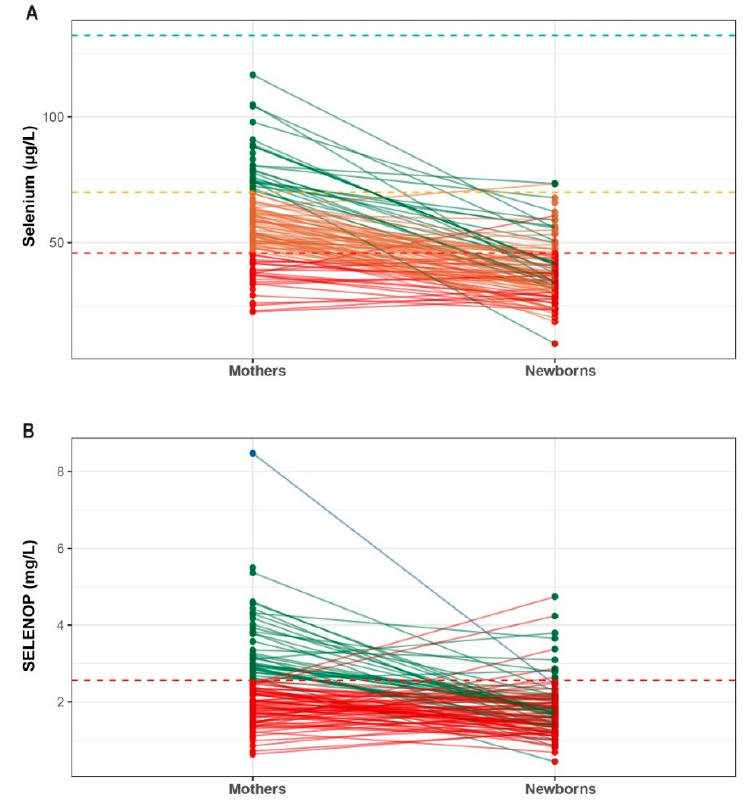
Figure 4. Comparison of Se and SELENOP concentrations between the mothers and their newborns. Despite the general tendency that concentration levels in newborns are lower as compared to those observed in their mothers, certain mother–infant pairs show particularly pronounced differences in concentration, suggesting that the interaction is subject to individual control mechanisms. ( A ) Color code indicates: Se deficiency (red) with [Se] < 45.9 µg/L, mild deficiency (orange) with [Se] > 45.9 µg/L and <70 µ g/L, or sufficiency (green) with [Se] > 70 µ g/L. ( B ) The color code used to highlight the SELENOP status includes: deficiency (red) with [SELENOP] < 2.56 mg/L, sufficiency (green) with [SELENOP] > 2.56 mg/L and <6.63 mg/L, versus excess (blue) with [SELENOP] > 6.63